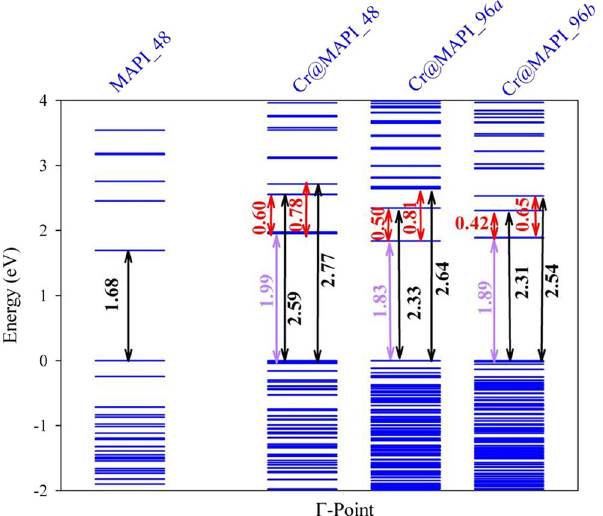
Figure 7. Eigenvalues calculated for MAPI and Cr@MAPI perovskites at Γ -point obtained after applying a rigid shift (based on G 0 W 0 + SOC approach) over PBEsol + SOC. Main energy differences measured at Γ -point (black, violet and red stand for VB-CB, VB-IGB and IGB-CB energy differences, respectively) are also shown. (Cr@MAPI_96 a ) and MAPI_96 b (Cr@MAPI_96 b ) stand for the unit cell with 48 atom, 96 atoms supercell with a ≈ b ≈ c and 96 atoms 2 × 1 × 1 supercell, respectively. The zero of energy has been set at the valence band